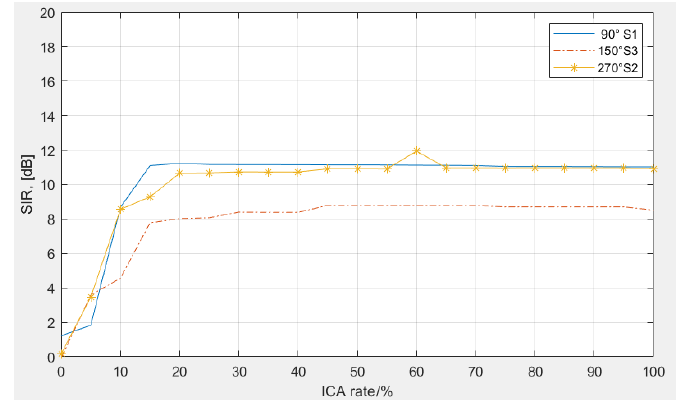
Figure 10. SIR improvement with modified separation under three sources in Room B.